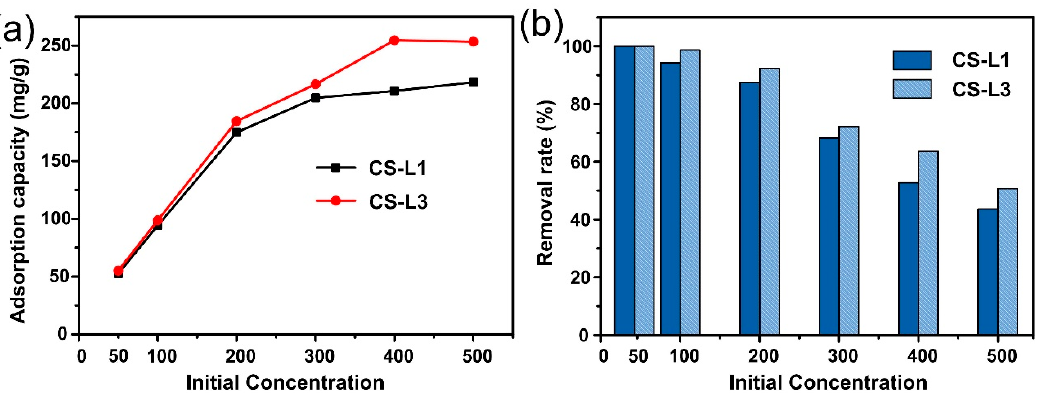
Figure 8. The influence of original Cu(II) concentration on ( a ) adsorption capacity and ( b ) the removal rate of CS membranes.